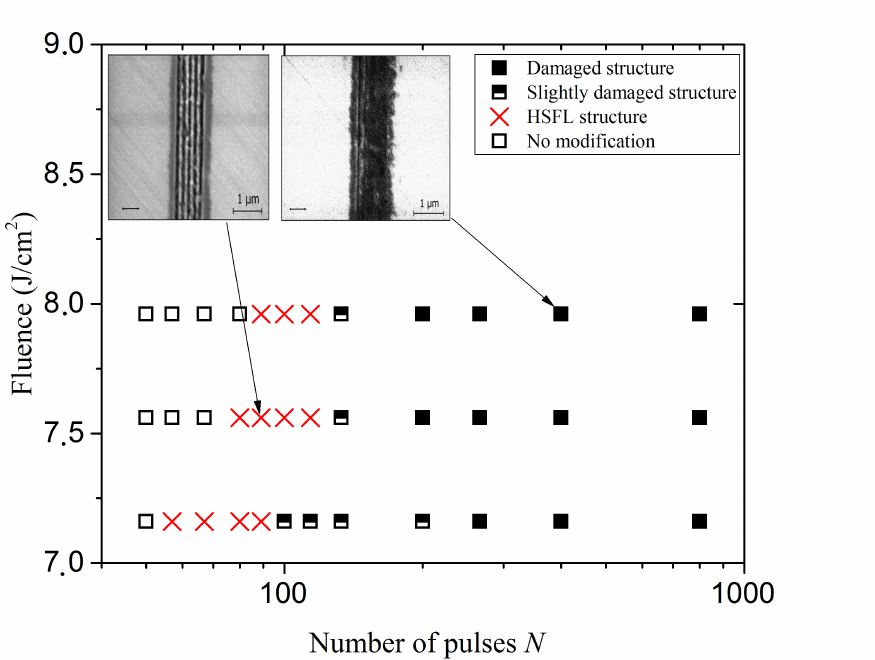
Figure 2. Summary of the modification results obtained during diamond surface irradiation by multipulse femtosecond laser for varying laser fluence and number of